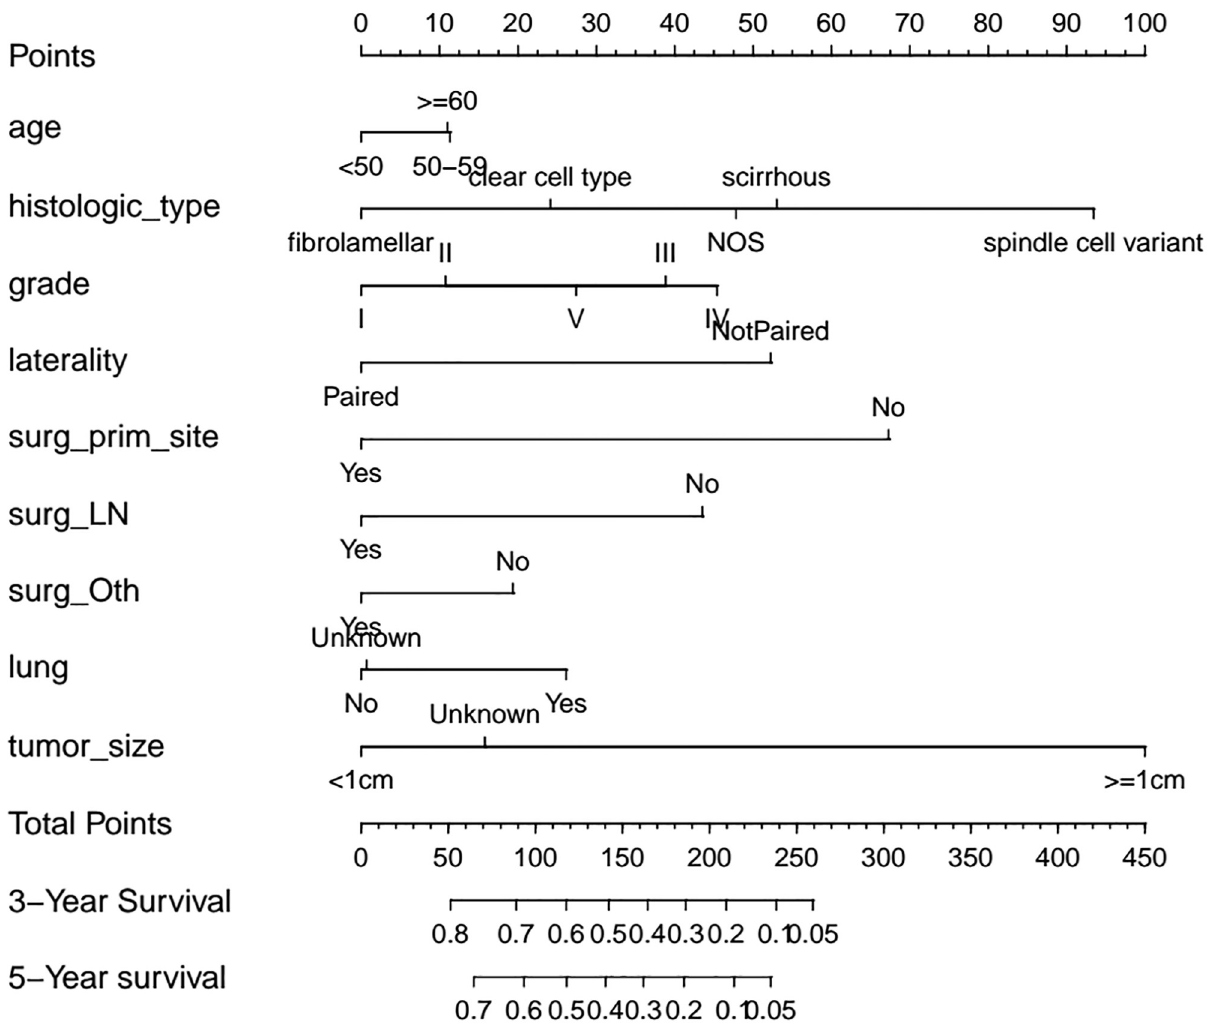
Fig 2. Nomogram model. The Nomogram model was established by 9 independent prognostic factors, which could predict the 3-year and 5-year survival for patients. In which histologic type 8173 (spindle cell variant) corresponds to maximum points for risk of death, followed by no primary site